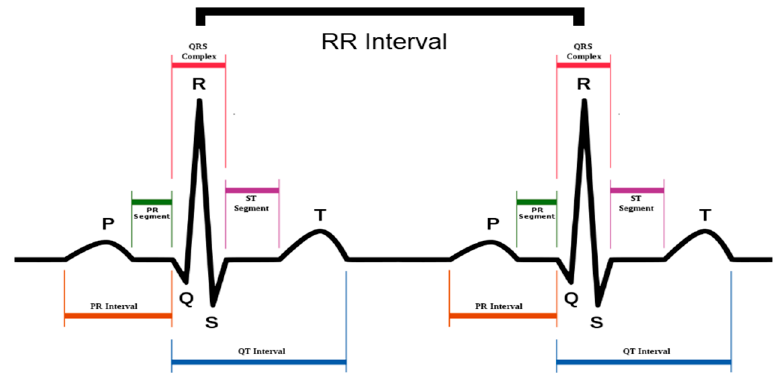
Figure 1. ECG signal